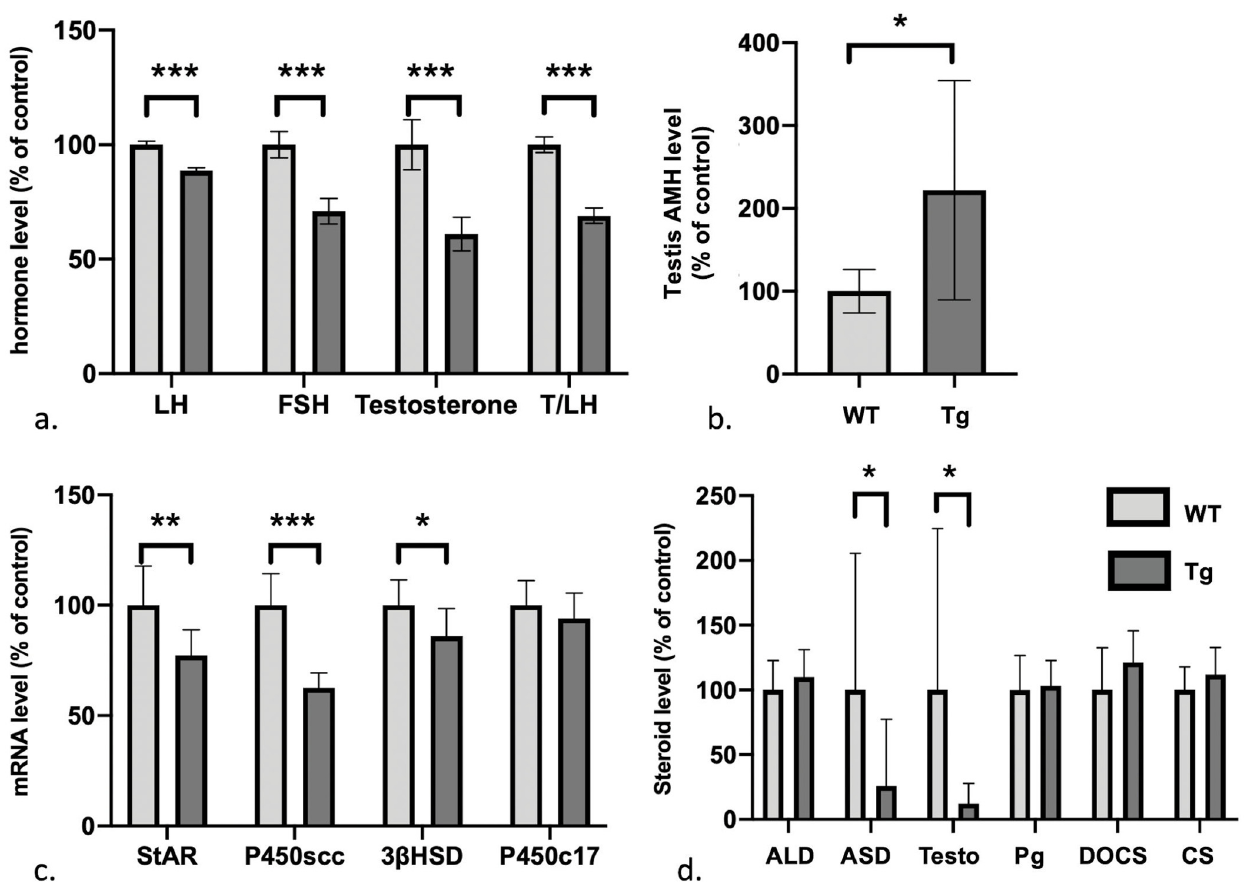
Figure 2. The gonadotrophic axis. Light grey: WT, dark grey: Tg; ( a , b , d ) gonadotropic axis and steroid level in plasma and testis; ( c ); mRNA levels of steroidogenesis enzymes in the testis. ALD: aldosterone, ASD: androstenedione, Testo: testosterone, Pg: progesterone, DOCS: deoxycorticosterone, CS: corticosterone. p value : 0.033 (*), 0.002 (**), <0.001 (***).